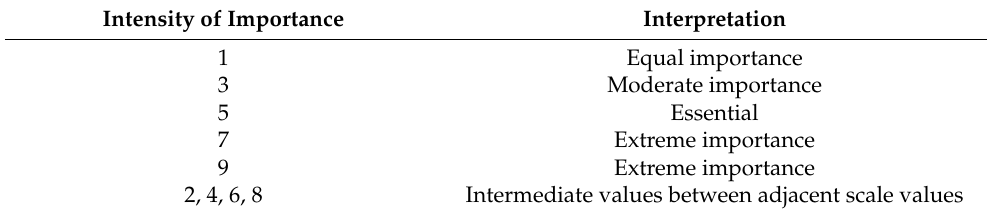
Table 1. Saaty’s 1–9 scale of relative importance [63].